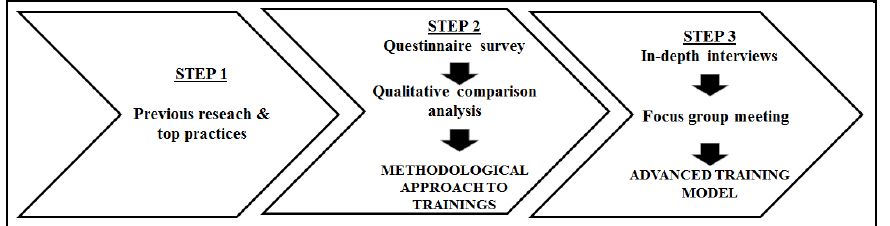
Fig. 3. Research design. Source: